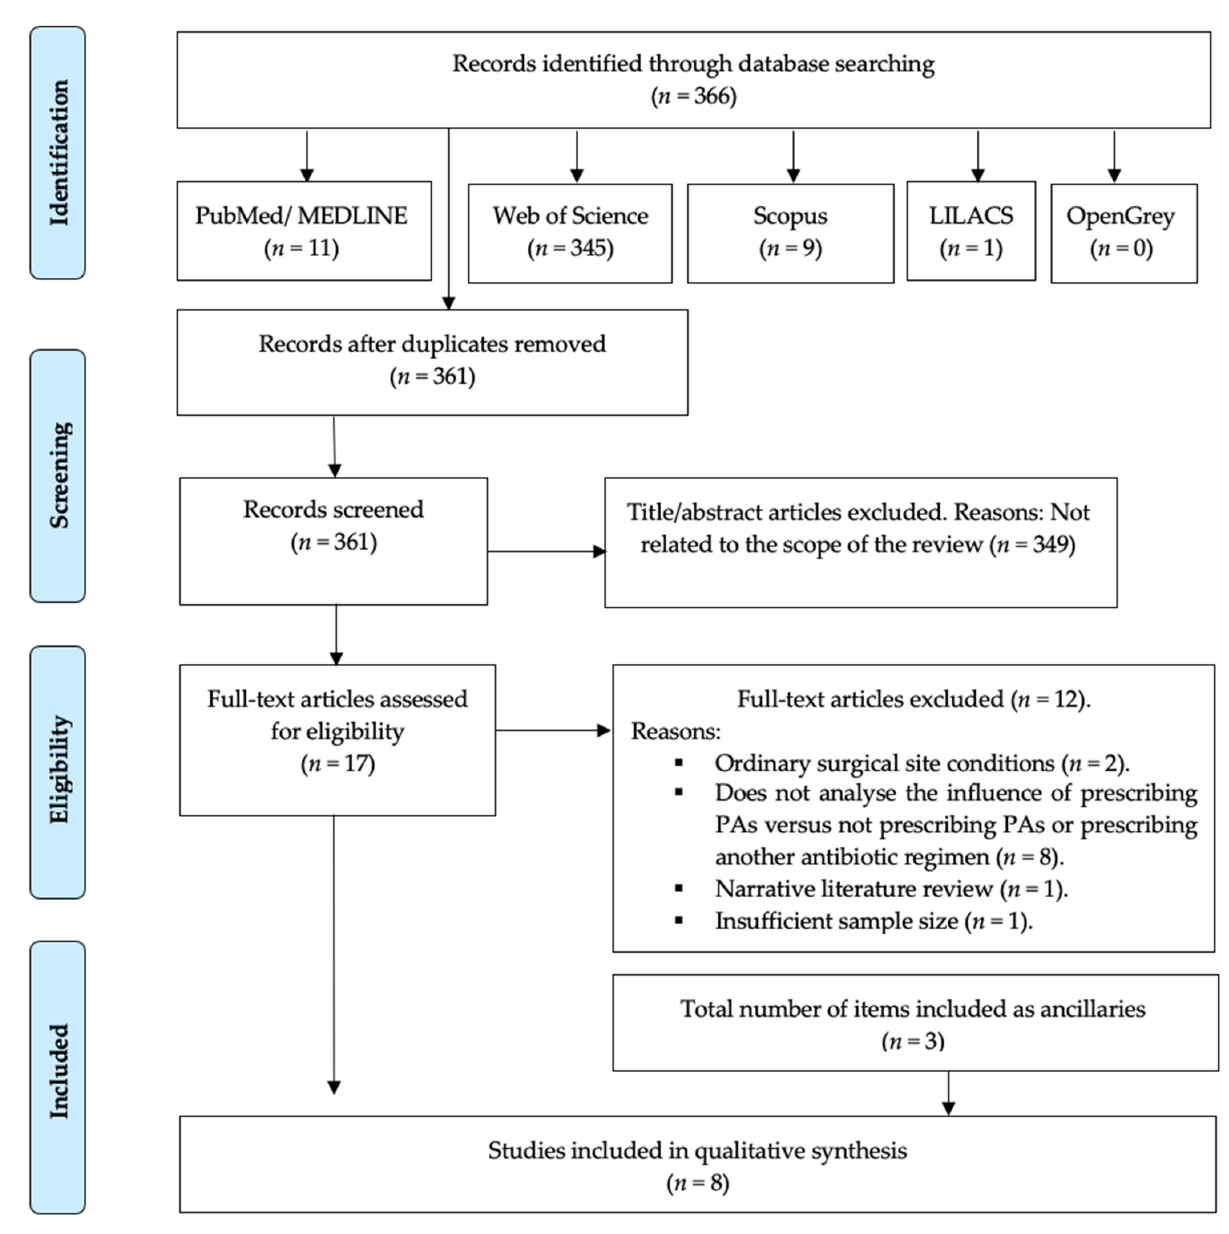
Figure 1. PRISMA ® flow diagram of the search processes and results.